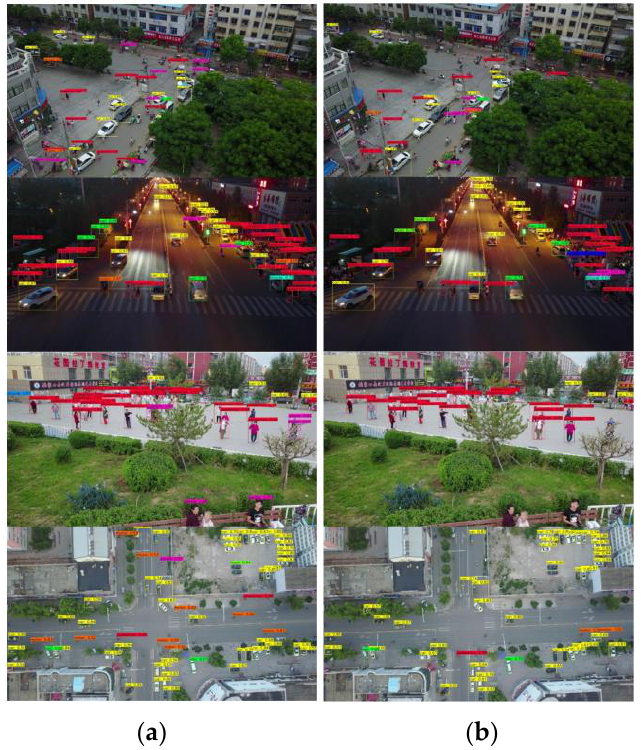
Figure 15. Detection results in Visdrone2019-Det. ( a ) Original version of YOLOv4; ( b ) YOLOv4 optimized for an edge device.